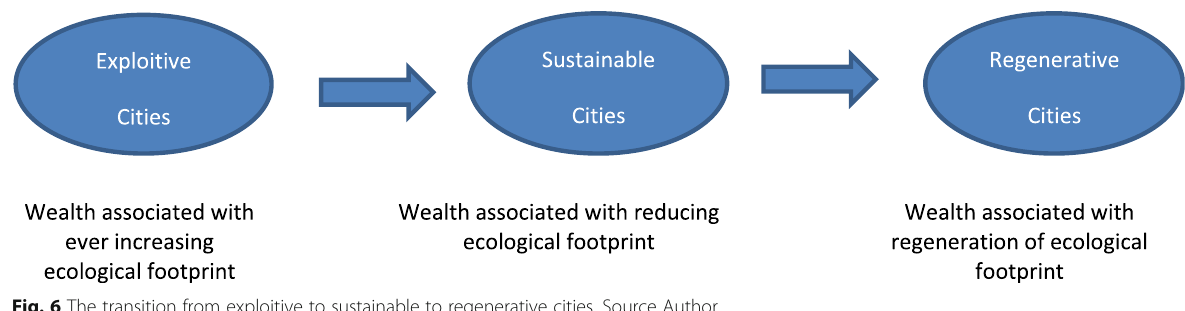
Table 1 Resource input variations between urban form types (Source: [43])) INPUT (Per Person Per Year)